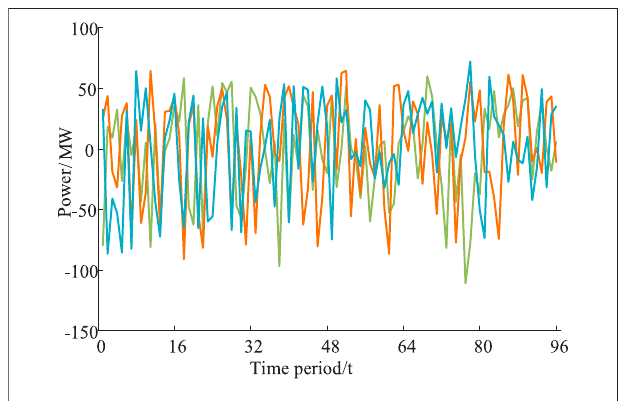
FIGURE 6 | Wind power error representation